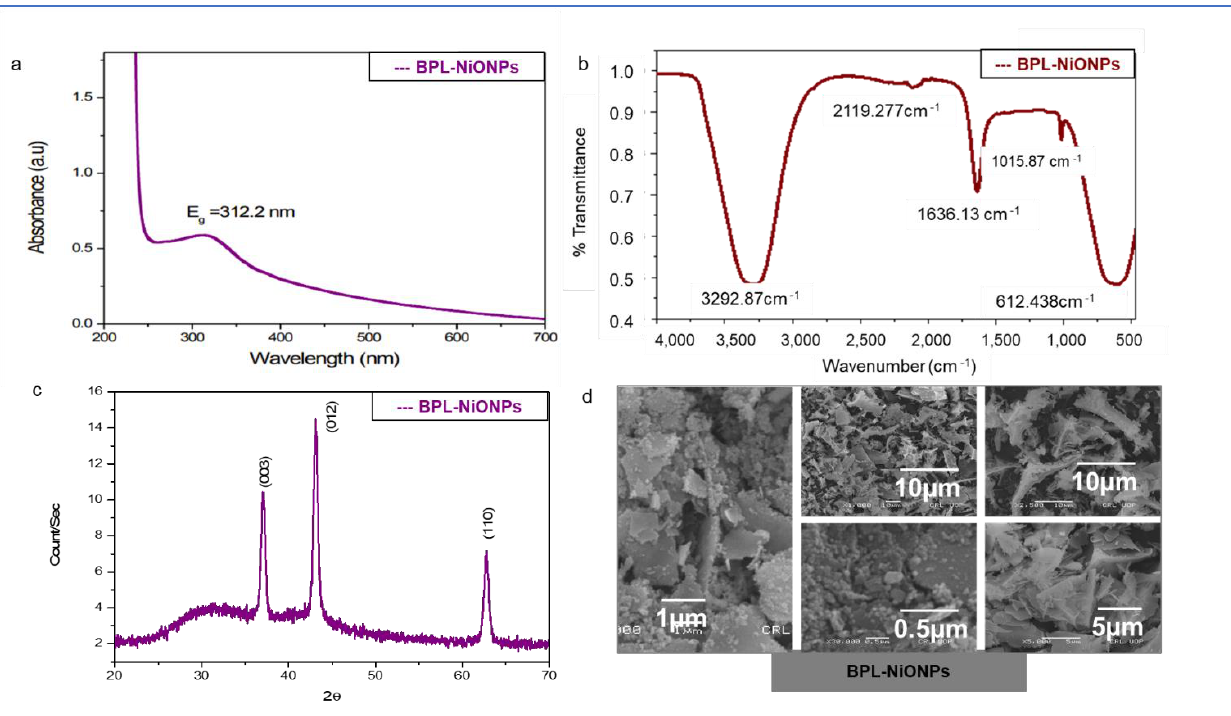
Figure 2. Spectroscopic analysis of BPL-NiONPs: ( a ) UV-Visible spectroscopy; ( b ) FTIR analysis; ( c ) XRD analysis; ( d ) SEM image (X1000, X5000, X2500, X10,000, X30,000).